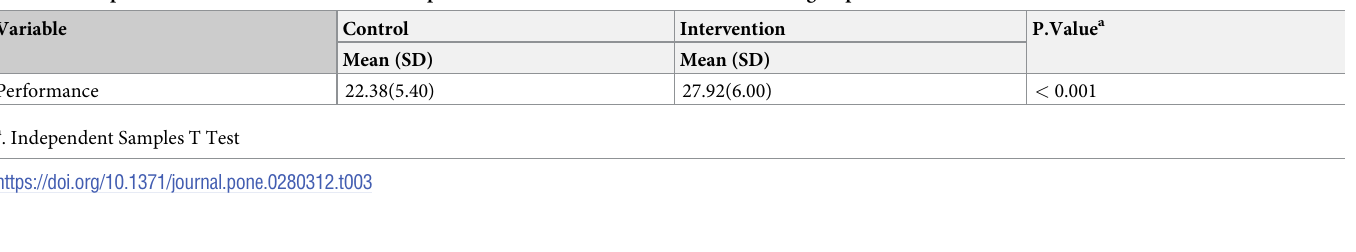
Table 3. Comparison of the mean score of students’ performance after the intervention in the two groups. Variable Control Intervention P.Value a